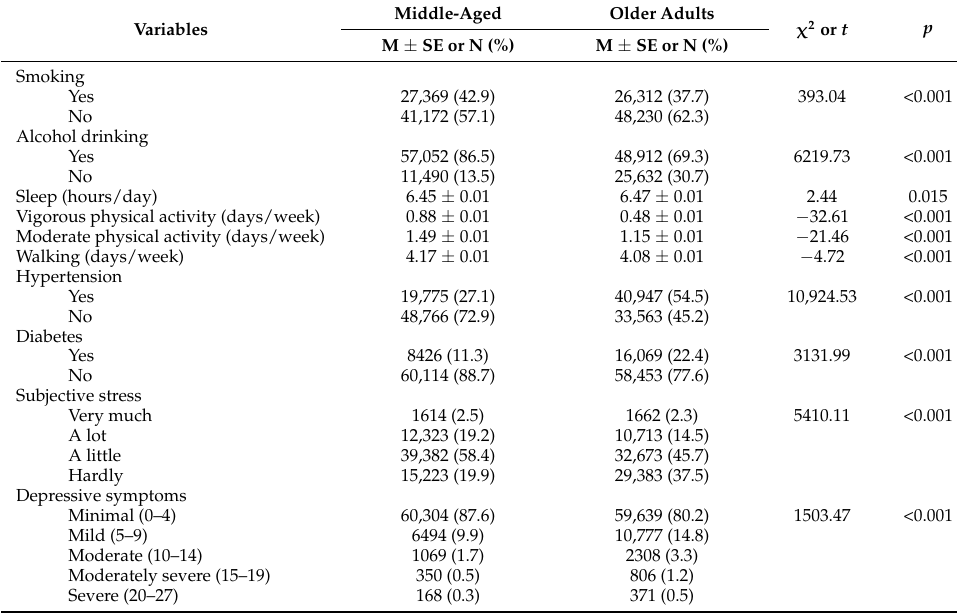
Table 2. Health related characteristics of the participants (N =